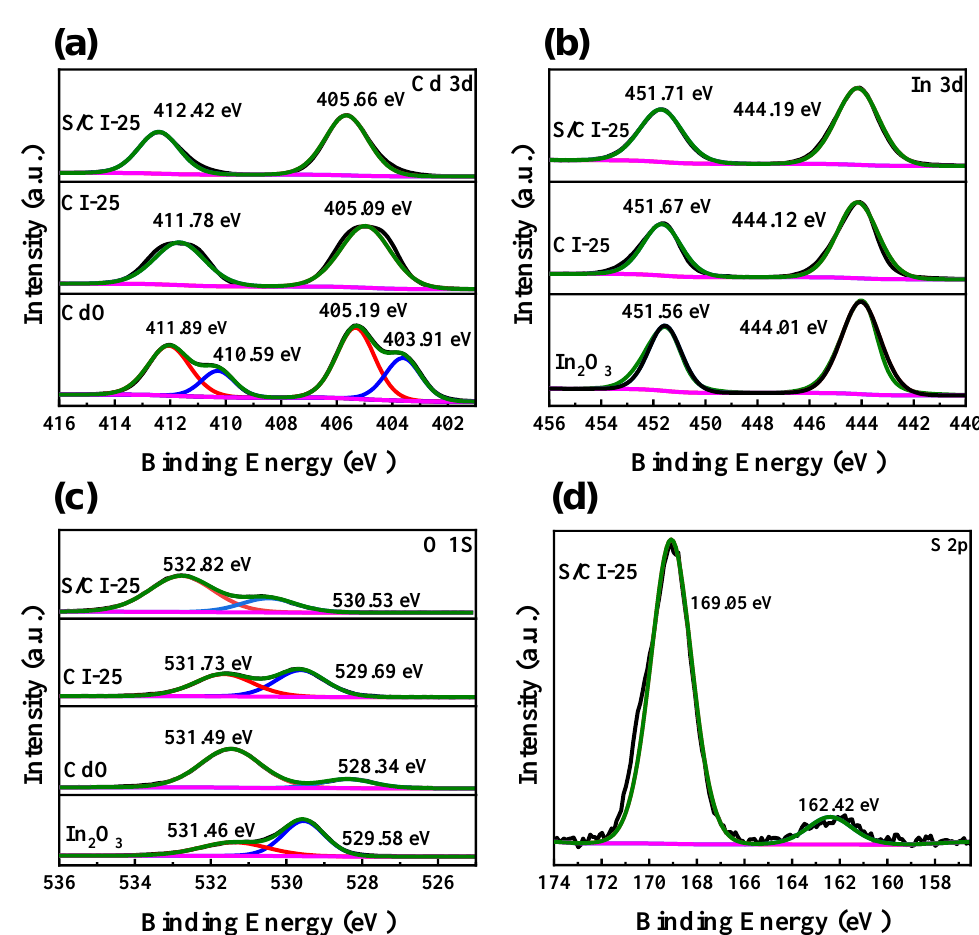
Figure 4. The XPS spectra of ( a ) Cd 3d, ( b ) In 3d, ( c ) O 1s, and ( d ) S 2p in the obtained samples.